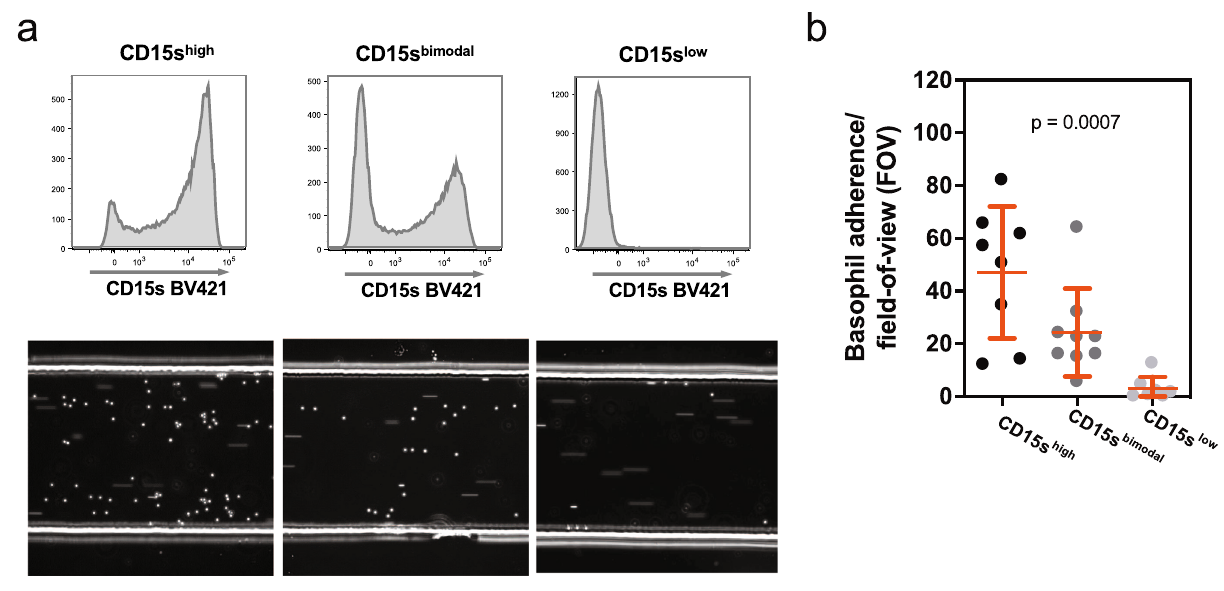
Fig. 2 Rolling of basophils on E-selectin-coated surfaces. a Flow chamber experiment with basophils from CD15s high , CD15s bimodal , and CD15s low individuals. Basophils isolated by negative selection were fl ushed through E-selectin-coated fl ow chambers. The upper panel shows the CD15s FACS pro fi le of the isolated basophils, the lower panel a snapshot taken during their passage through the fl ow chamber. The dots represent adherent cells rolling on the surface, the streaks non-adherent cells carried by the stream; videos can be downloaded as Supplementary Movie 1. b Statistical analysis. The dots indicate the number of adherent basophils per fi eld of view (FOV). Each dot represents an independent frame. The number of adherent basophils were found to be signi fi cantly different between the basophil subsets via Kruskal – Wallis test ( p =